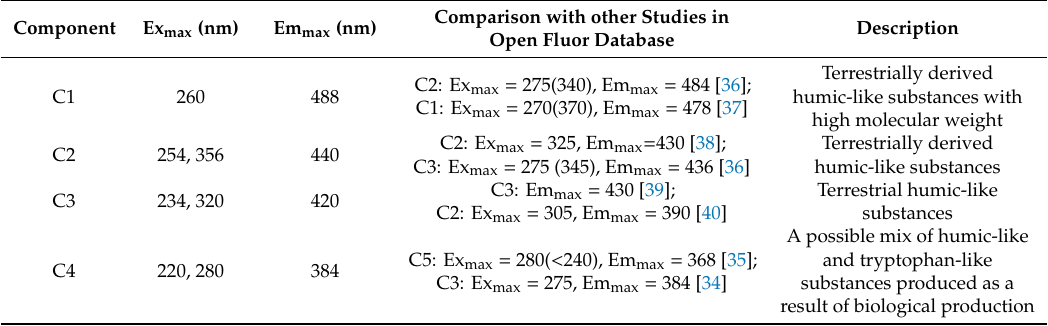
Table 2. Excitation and emission maxima of the fluorescent components of FDOM identified in the overlying water of Lake Hulun by parallel factor (PARAFAC) modeling. FDOM, fluorescent dissolved organic matter.